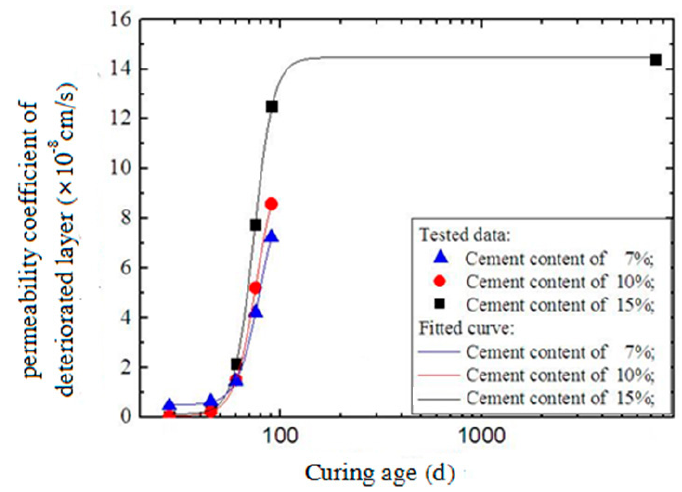
Figure 14. Theoretical evolution of the permeability coefficient of the deteriorated layer.